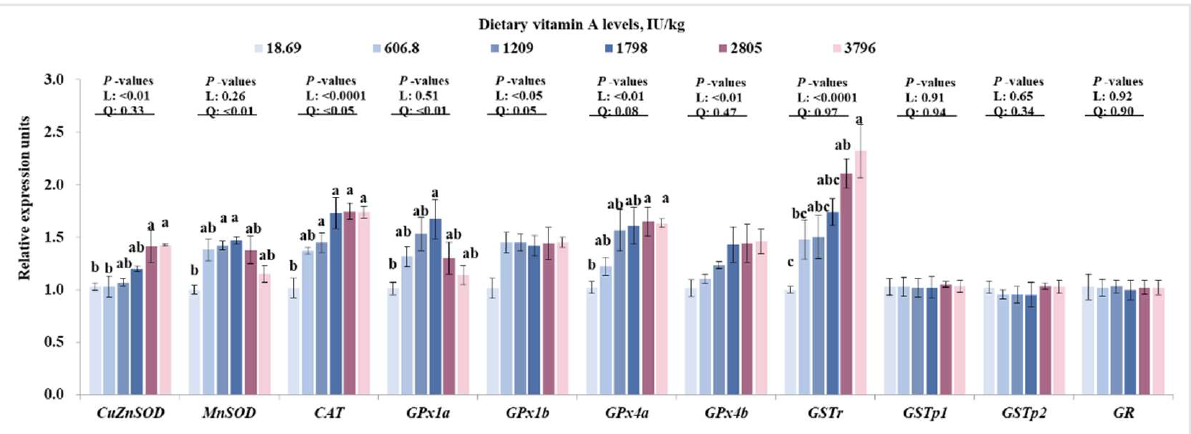
Figure 3. Effects of dietary vitamin A on relative mRNA levels of antioxidant enzymes genes in muscle of on-growing grass carp. Data are means ± SEM of three replicate groups, two fish for each replicate ( n = 3). a, b, c within a column, means without a common lowercase superscript differ ( p < 0.05). p -values underlined with a solid line indicate a linear and quadratic response to dietary vitamin A levels. SEM = standard error of the mean; L = linear; Q = quadratic; CuZnSOD = copper/zinc superoxide dismutase; MnSOD = manganese superoxide dismutase; CAT = catalase; GPx1a = gluta- thione peroxidase 1a; GPx1b = glutathione peroxidase 1b; GPx4a = glutathione peroxidase 4a; GPx4b = glutathione peroxidase 4b; GSTr = glutathione-S-transferase r; GSTp1 = glutathione-S-transferase p1; GSTp2 = glutathione-S-transferase p2; GR = glutathione reductase.